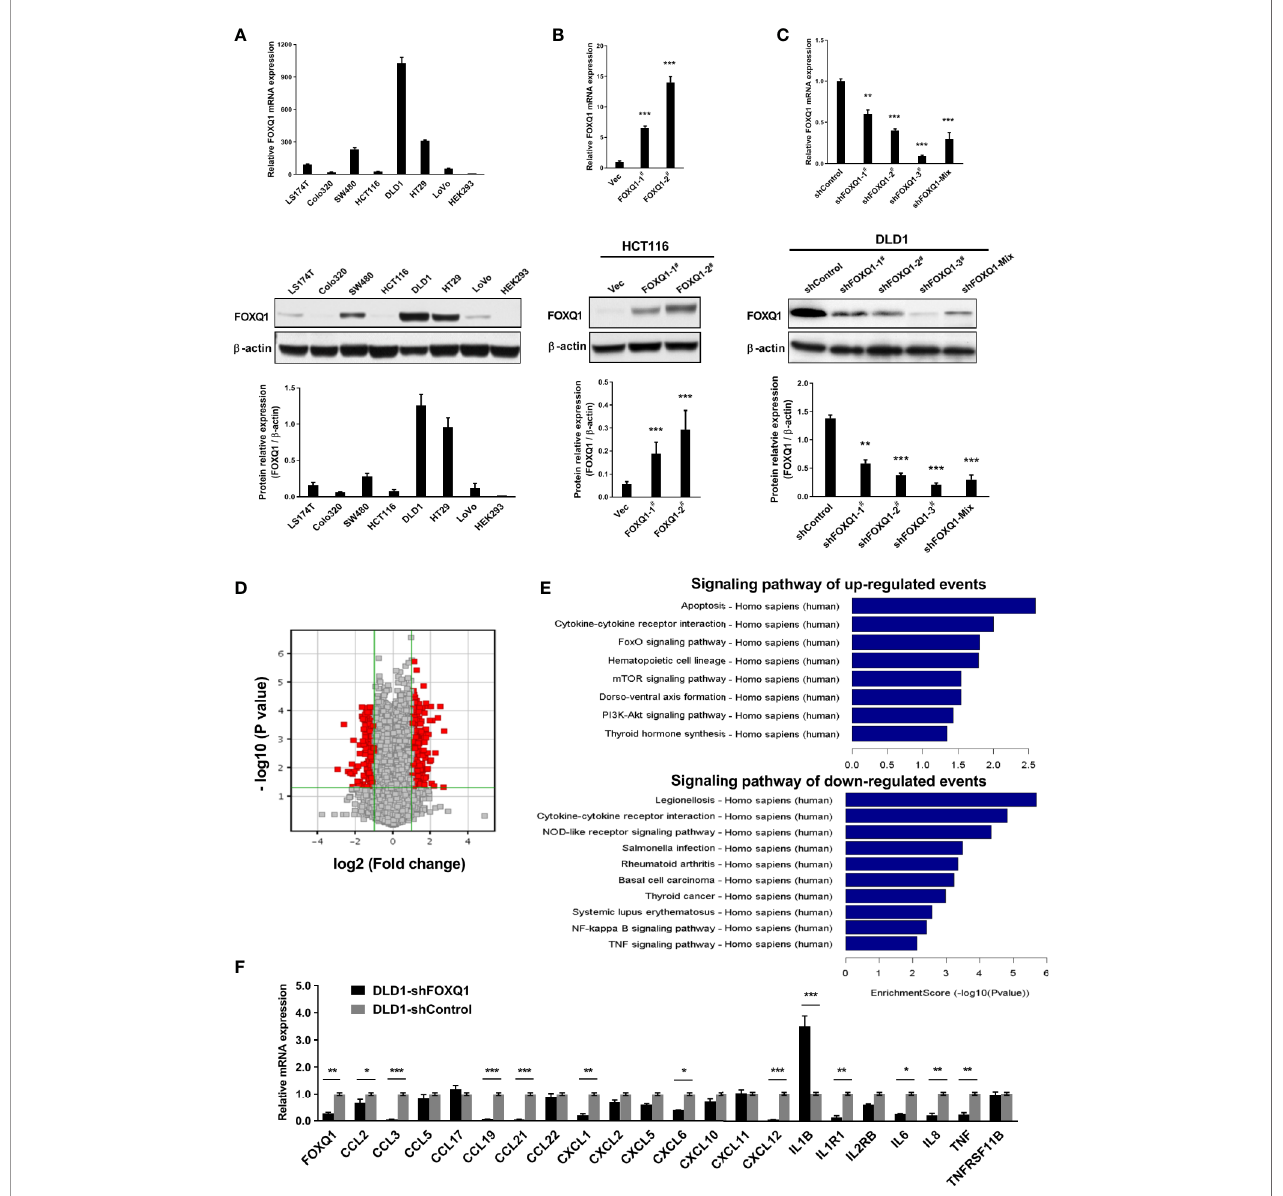
FIGURE 1 | FOXQ1 modulates the expression of genes that affect the tumor microenvironment (TME) during colorectal cancer (CRC) tumorigenesis. (A) Relative endogenous FOXQ1 expression in 7 CRC cell lines; HEK293 was used as internal control. (B) Increased expression of FOXQ1 after transfection of HCT116 with either FOXQ1-1 # or FOXQ1-2 # ; HCT116 transfected with Vec was used as control. (C) Reduction in FOXQ1 after transfection of DLD1 with shFOXQ1-1 # , shFOXQ1- 2 # , shFOXQ1-3 # , or shFOXQ1-Mix; DLD1 transfected with shControl was used as control. (D) Volcano Plot visualizing differentially expressed genes (DEGs) between DLD1-shFOXQ1 and DLD1-shControl. The red point in the plot represents the DEGs with statistical signi fi cance. (E) Signi fi cant pathway analysis of up- and down- regulated DEG events; pathways are sorted in descending order based on enrichment score. Left, Pathway Name; right, bar graph representing the enrichment score [-log10 ( P value)]. (F) Validation of the expression pro fi les of a subset of DEGs involved in cytokine-cytokine receptor interaction and the TNF signaling pathway by using qRT-PCR. * P <0.05, ** P <0.01, *** P <0.001 indicated a signi fi cant difference as compared to the control group (two-tailed, unpaired Student ’ s t -test). Bars represent mean ± S.E. of three independent Figure 1C) . Transcriptional microarray analysis identi fi ed 431 DEGs (255 upregulated and 176 downregulated) between DLD1- shFOXQ1 and DLD1-shControl cells (Figure 1D , Table S4 ,